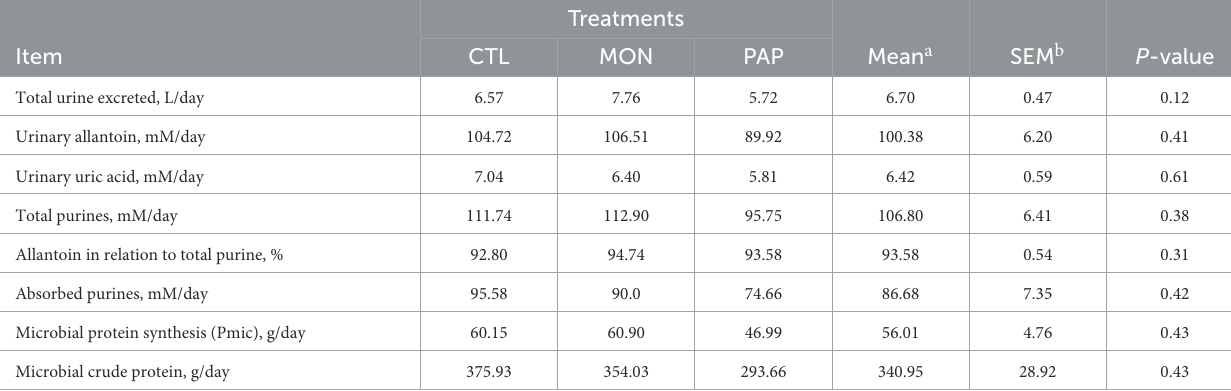
TABLE 5 Microbial protein synthesis in cattle induced to ruminal acidosis receiving polyclonal antibodies (PAP) or monensin (MON).